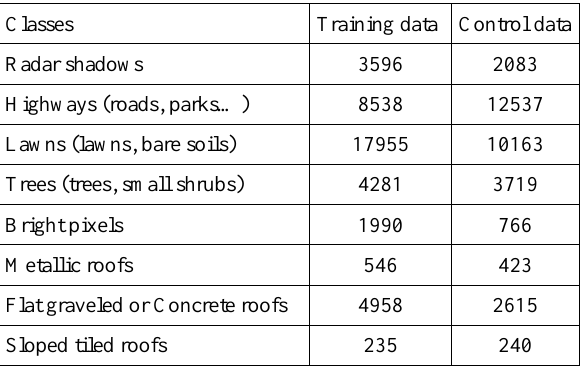
Table 1. Training and control samples in pixel number